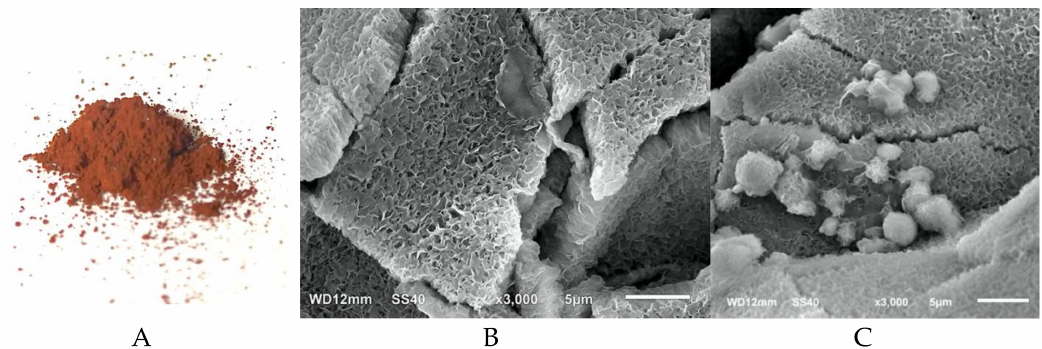
Figure 1. Synthesized NiFe 2 O 4 nanoparticles showed as a dark brown powder ( A ). The porous structure of cryogel is made of alginate ( B ) and alginate with NiFe 2 O 4 nanoparticles ( C